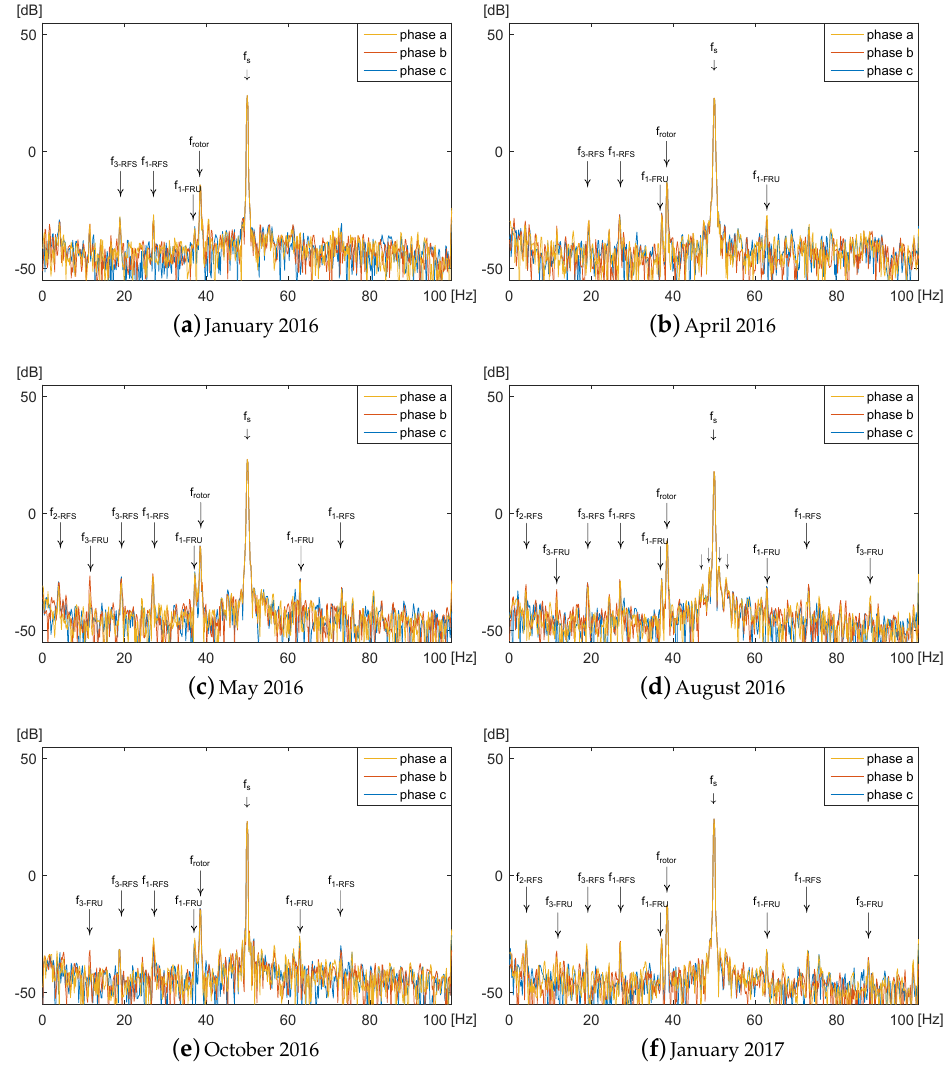
Figure 4. January 2016–January 2017. Evolution of current spectra at sub-synchronous